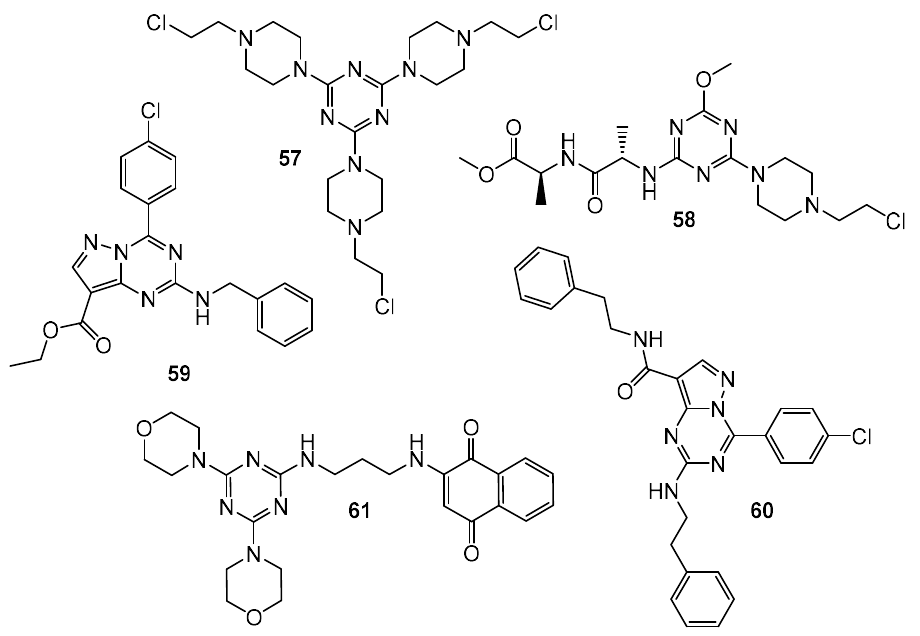
Figure 12. Structures of compounds 57–61 .